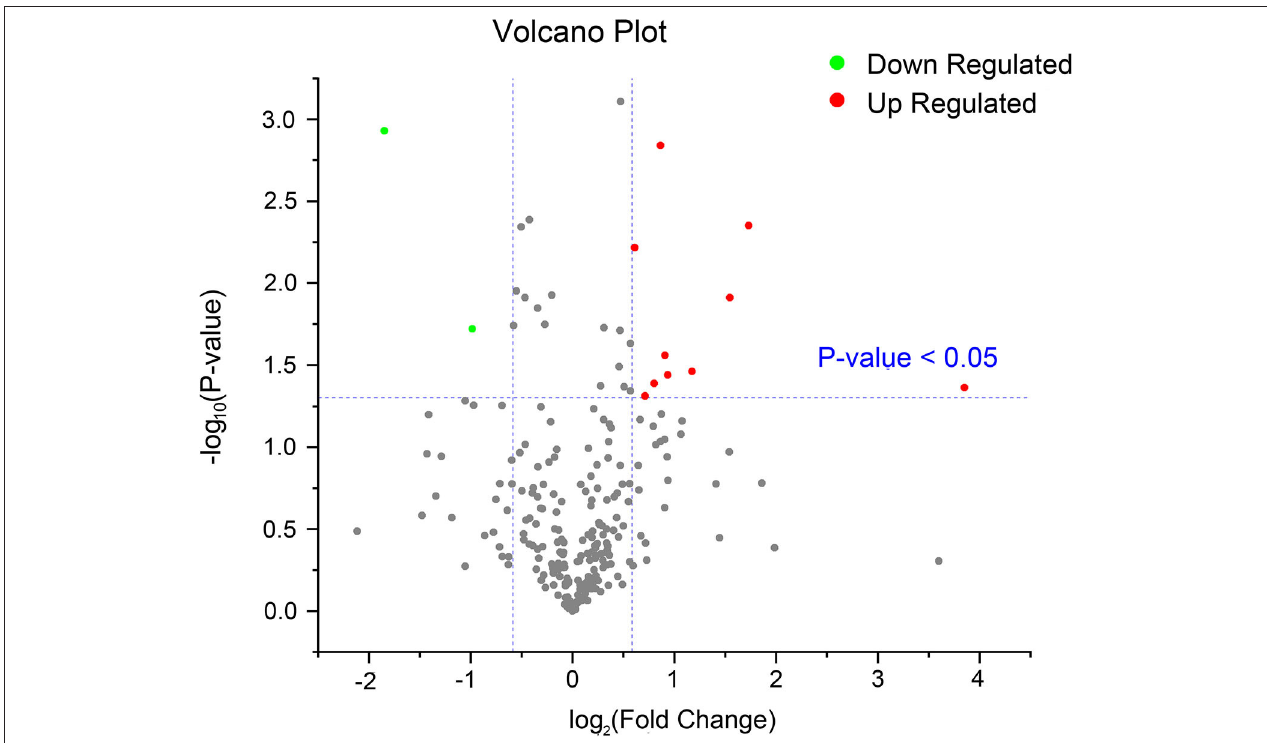
FIGURE 2 | A volcano plot of common proteins identified in the serum of early pregnant and non-pregnant jennies. This plot was drawn on the basis of the fold change and P -value between the P and NP groups. Red and green dots represent upregulated and downregulated common proteins, respectively (fold change ≥ 1.5 and P < 0.05). Gray dots represent proteins without any